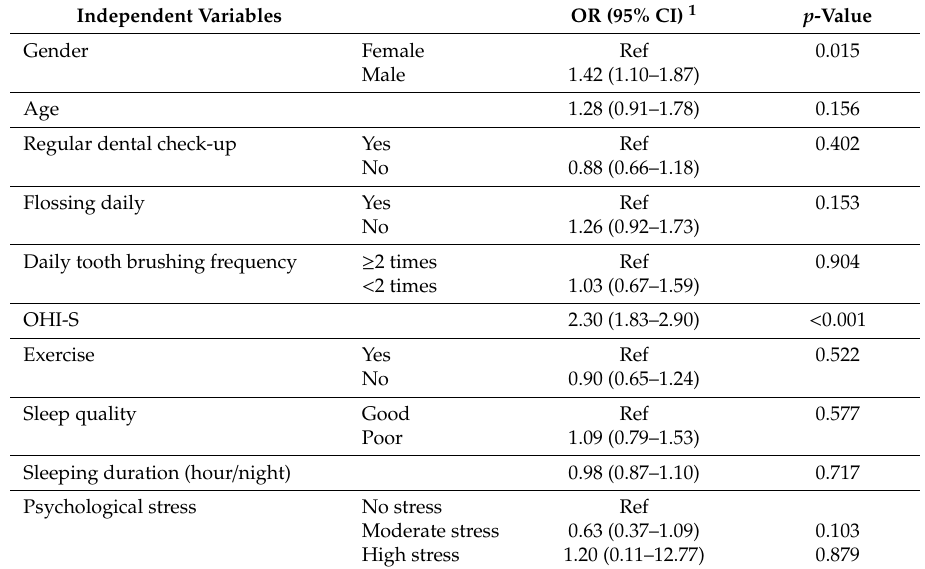
Table 3. Conditional odds ratios (ORs) and 95% confidence intervals (CIs) for periodontal